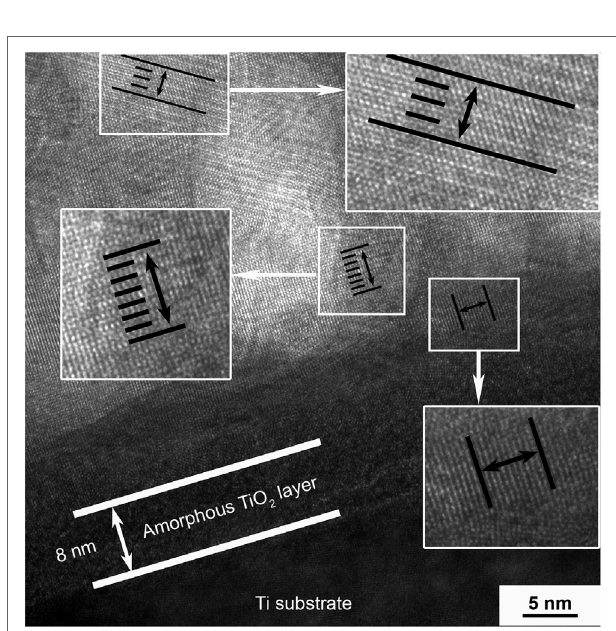
FigUre 6 | Interplanar d -spacing measured in a fragment of high-resolution TEM of the HA-Zn